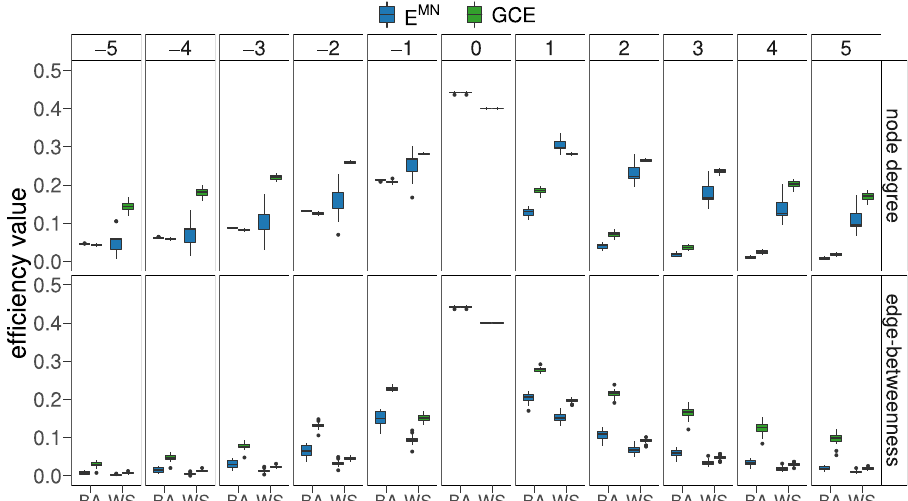
Fig. 4 Comparison of weighted ef fi ciency descriptors for synthetic networks with different topologies and fl ows. Topologies are generated from the Barabasi – Albert (BA) and Watts – Strogatz (WS) models while fl ows are generated according to (2) and (3) for varying β ∈ [ − 5, 5] as speci fi ed at the top of each column. The parameter β controls the agreement — direct (inverse) proportionality for β ≥ 0 ( β < 0) — between the outgoing strength of the nodes and their degree (in the plot labeled “ node degree ” ) and between the weight of edges and their edge-betweenness (in the plot labeled “ edge-betweenness ” ). The descriptors are the global communication ef fi ciency GCE and the max-normalized ef fi ciency E MN . See Fig. 2 for the detailed legend of